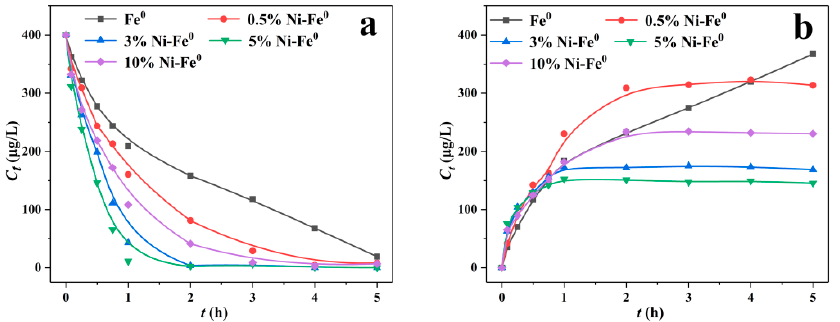
Figure 4. Degradation of TCE by Ni-nZVI with different nickel contents. Initial TCE concentration = 400 ± 10 μ g/L; initial pH = 7.0 ± 0.1, initial DO = 6.5 ± 0.1; nZVI for all experiments = 1000 mg/L; reaction volume = 40 mL. ( a ) TCE; ( b ) DCE.